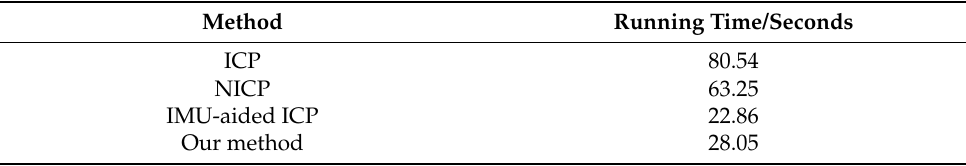
Table 4. Comparison of operating time for 300-frame